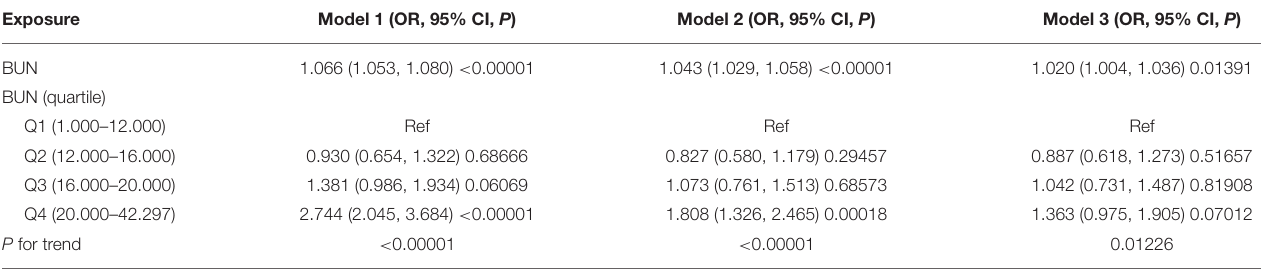
TABLE 2 | The results of the multivariate analysis. Exposure